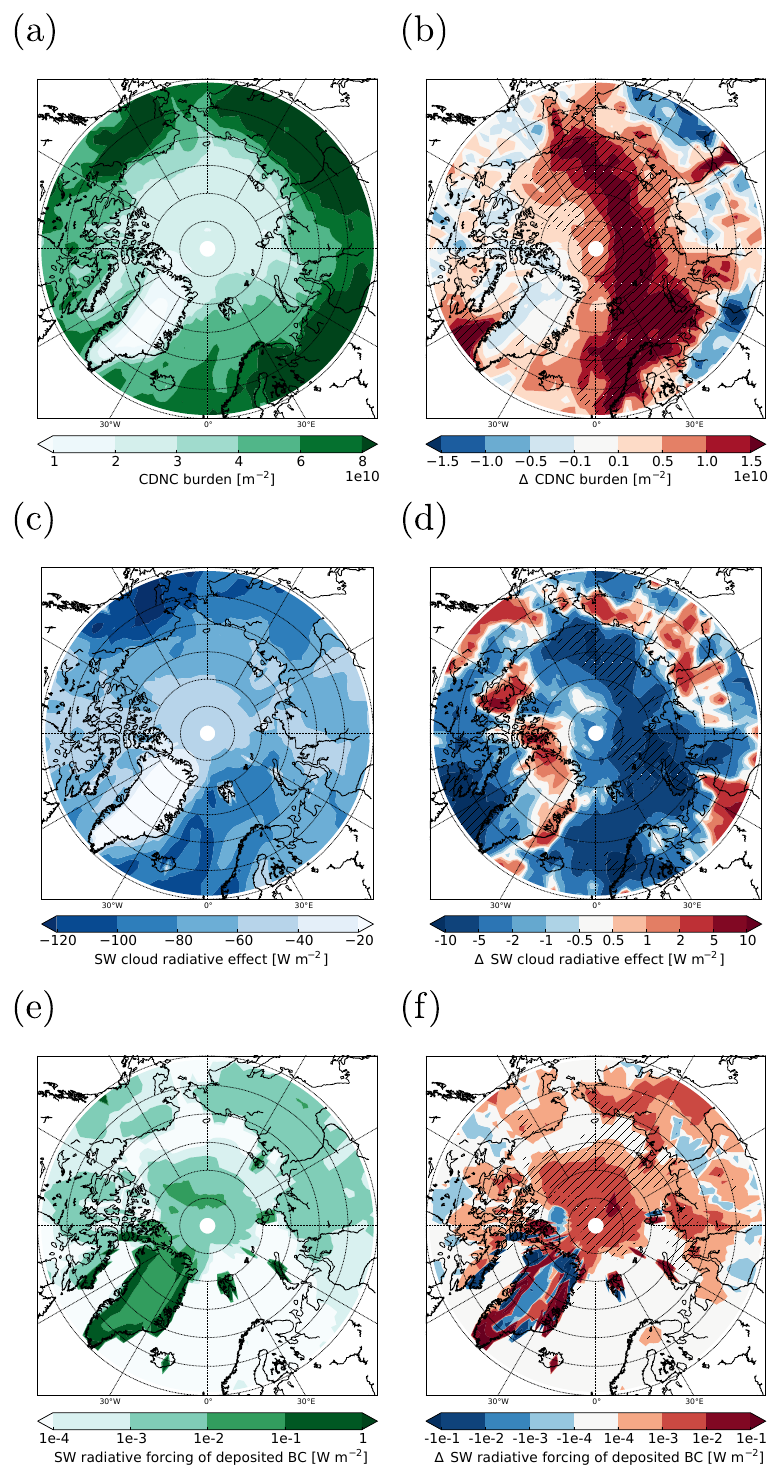
Figure 14. The impact of additional ship emissions in the Arctic on (b) in-cloud CDNC burden, (d) SW CRE, and (f) radiative forcing due to BC deposition on snow. In (a) , (c) , and (e) , the reference without additional ship emissions is shown (arctic_2050). Hatched areas are significant at the 95% confidence level. Panels (a) to (d) show results for late summer (July–August), (e) and (f) for early autumn (September–October). Note that the scale in (e) and (f) is